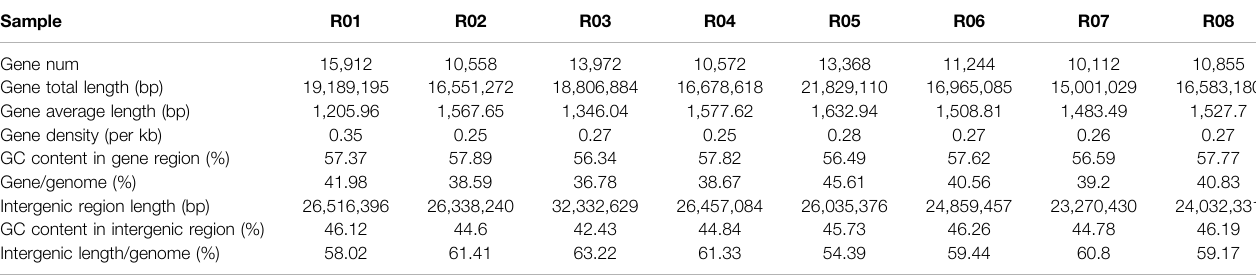
TABLE 3 | Gene information statistics. Sample